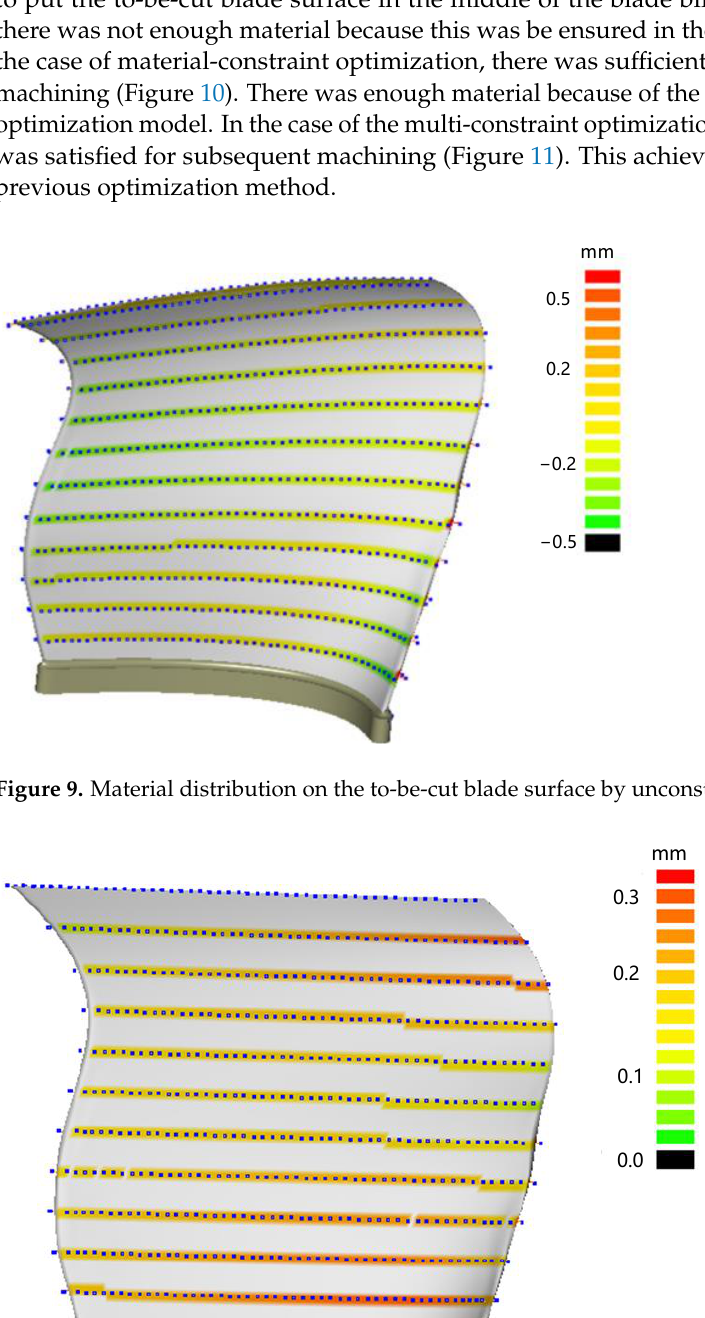
Figure 11. Material distribution on the to-be-cut blade surface by multi-constraint optimization. The distances between the optimized profile curves and the design profile curves for the unconstrained optimization are plotted in Figure 12. It can be observed that the profile curves were outside the profile tolerance. That is to say, the to-be-cut blade surface was not a qualified surface for generating a toolpath. Figure 13 shows the distances between the optimized profile curves and the design profile curves for the material-constraint op- timization. Similarly, the to-be-cut blade surface is not a qualified surface due to the off-